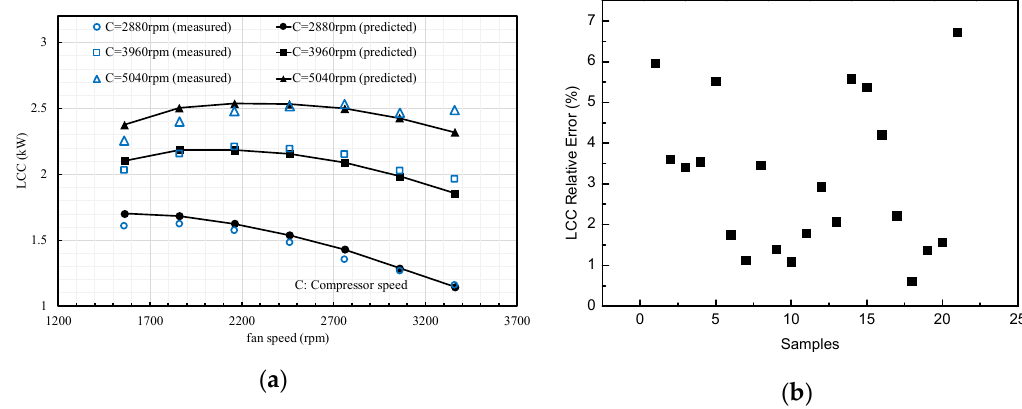
Figure 6. Comparison results for the measured and predicted values of LCC, ( a ) LCC; ( b ) Relative error.